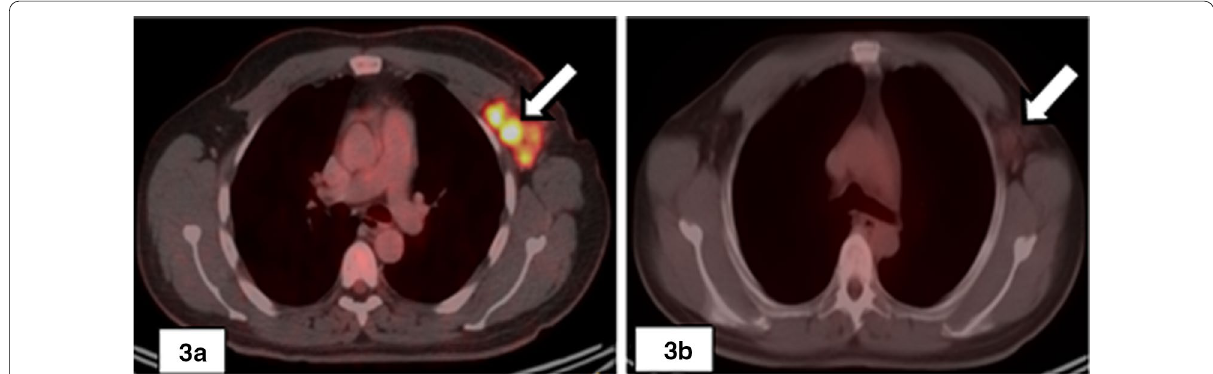
Fig. 3 36-year-old male patient, pathologically proved case of HL: initial PET/CT shows ( a ) FDG-avid amalgamated left axillary nodes (exhibiting: SUVmax of 8.87, MTV of 32.3cm 3 , and TLG of 170 gm/ml), post-treatment PET/CT showed ( b ) CMR (exhibiting: SUVmax of 2, MTV of 11.8cm 3 , and TLG of 12.7 gm/ml)